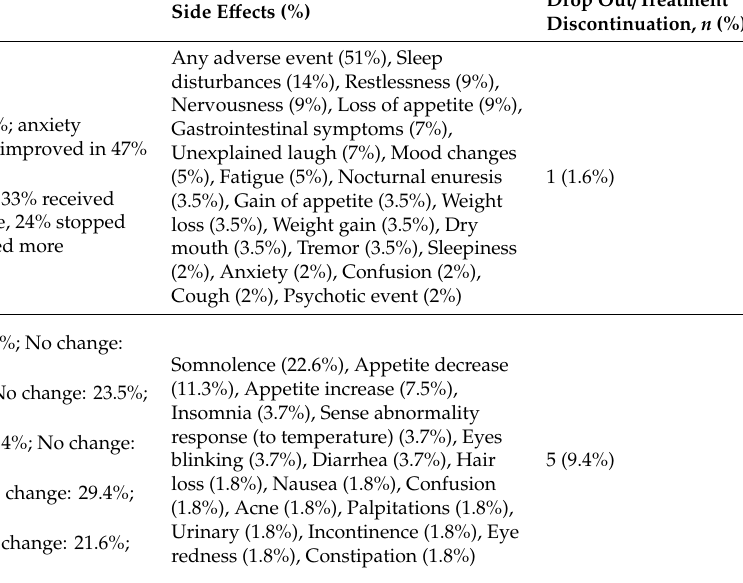
Drop Out / Treatment Discontinuation, n